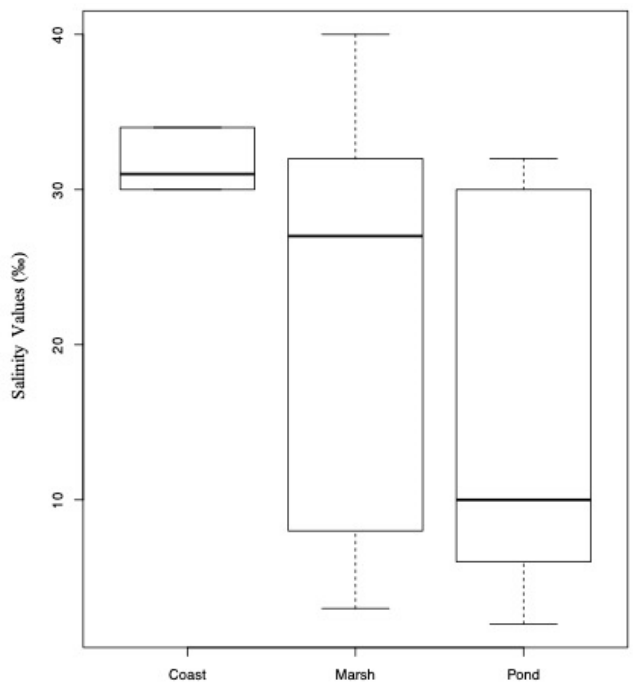
Figure 8. Boxplot showing salinity ranges for each ecosystem. The type of ecosystem was a significant predictor of salinity ( p = 0.042). Diversity 2019 , 11 , x FOR PEER REVIEW